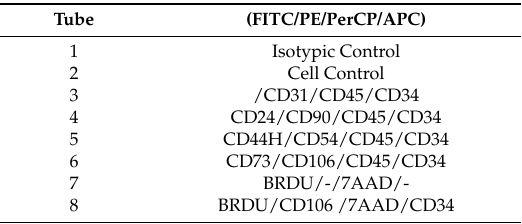
Table A1. Panel of the flow cytometry